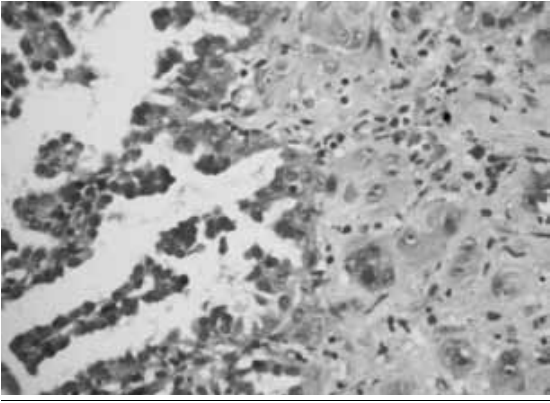
figurE 7 – HEE affecting lymph node (HE, 20×) Polygonal neoplastic cells with wide eosinophilic cytoplasms,